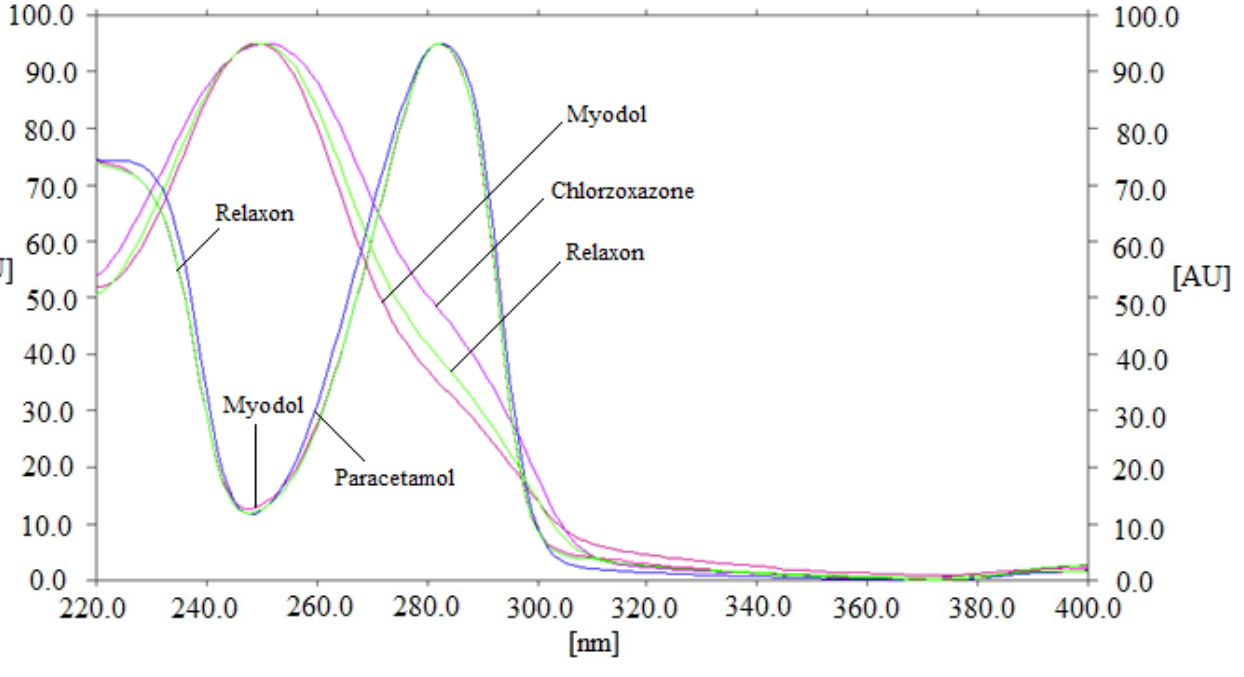
Figure 3. Overlaid UV-absorption spectra of standard CZN and PCT and CZN and PCT in commercial Relaxon capsules and commercial Myodol tablets.